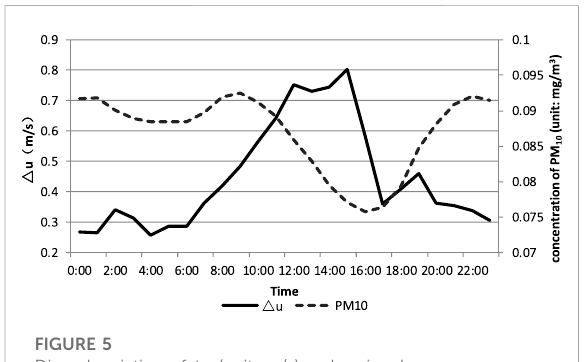
FIGURE 5 Diurnal variation of Δ u (unit: m/s) and regional average concentration of PM 10 (unit: mg/m 3 ).